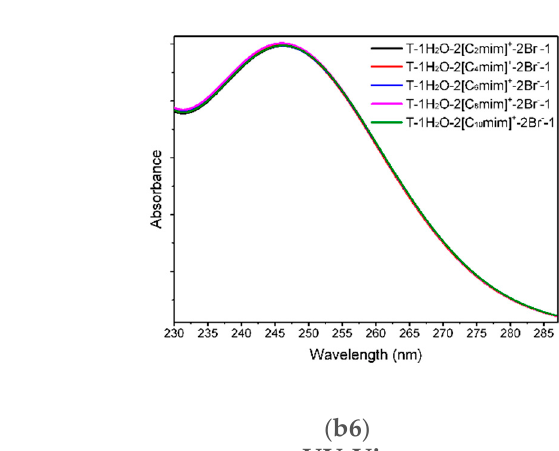
Figure 5. ( a1 – a6 ) The IR vibrational spectra and ( b1 – b6 ) UV-Vis absorption spectra of the thymine monomer and the corresponding microhydrates, T-4H 2 O-Br − -1, T-3H 2 O-[C n mim] + -Br − -1, T-2H 2 O- [C n mim] + -2Br − -1, and T-1H 2 O-2[C n mim] + -2Br − -1 ( n = 2, 4, 6, 8, 10). The modes v1, v2, v7, v8, and v9 dominating in absorption peaks located at 3636, 3600, 1774, and 1723 cm − 1 are assigned to ν N1-H, ν N3-H, υ C2=O7 + ρ N1-H, υ C4=O8 + ρ N3-H, and υ C5=C6 + ρ N3-H + ρ C6-H for the isolated thymine, in order.